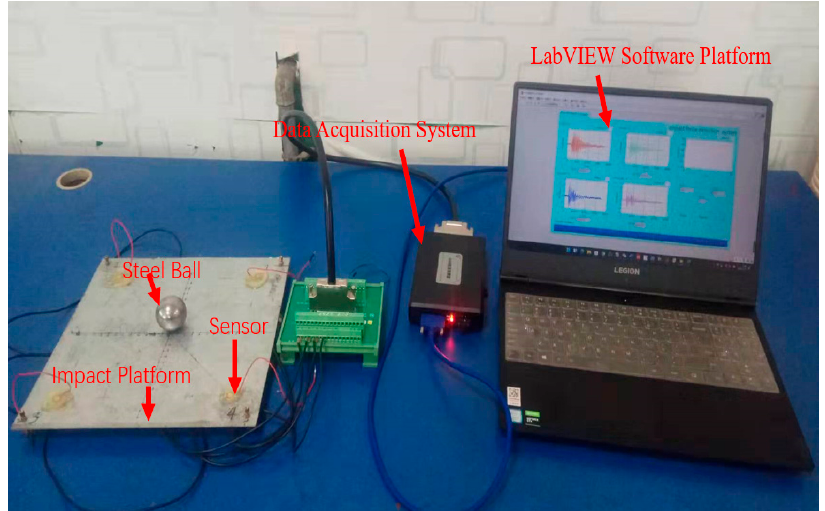
Figure 16. Impact detection system.